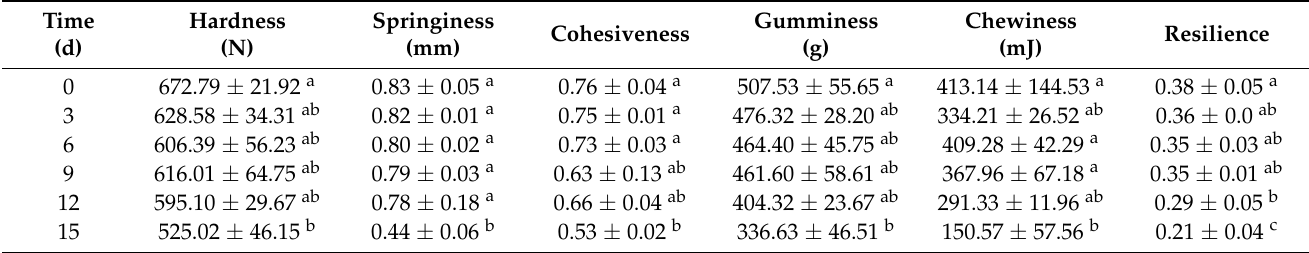
Table 2. Texture profile analysis of egg yolk with salting